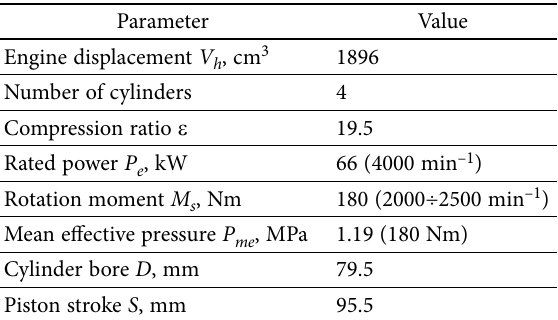
Table 1. Technical data on 1Z diesel engine